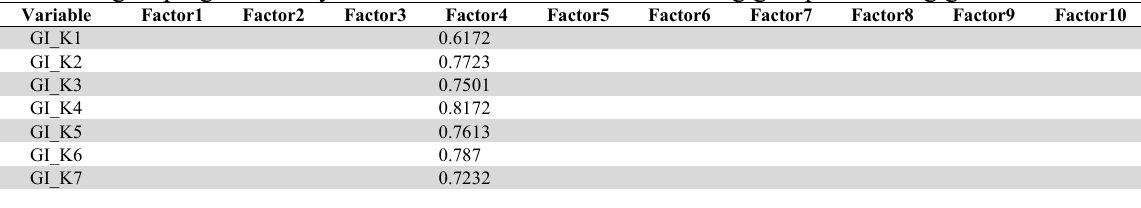
Results of grouping factors by the matrix of rotation factor loading groups affecting green investment